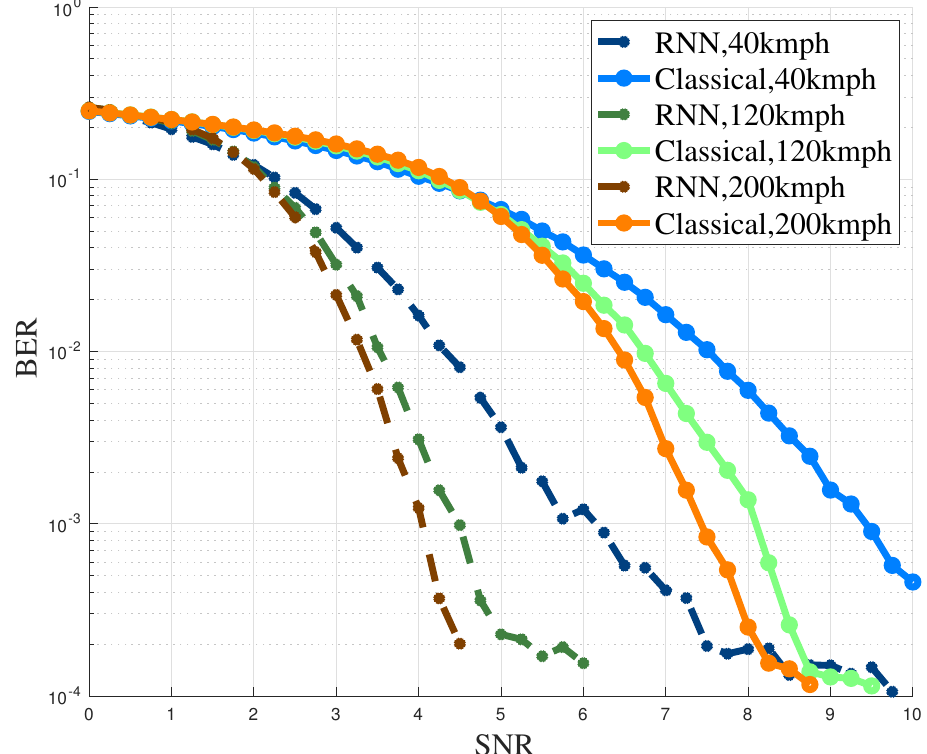
Figure 4. LPLT (ISD = 15 km). Performances of the RNN vs. classical Terrestrial Broadcasting system for the same throughput (138 kbit/s) and different user speeds. r